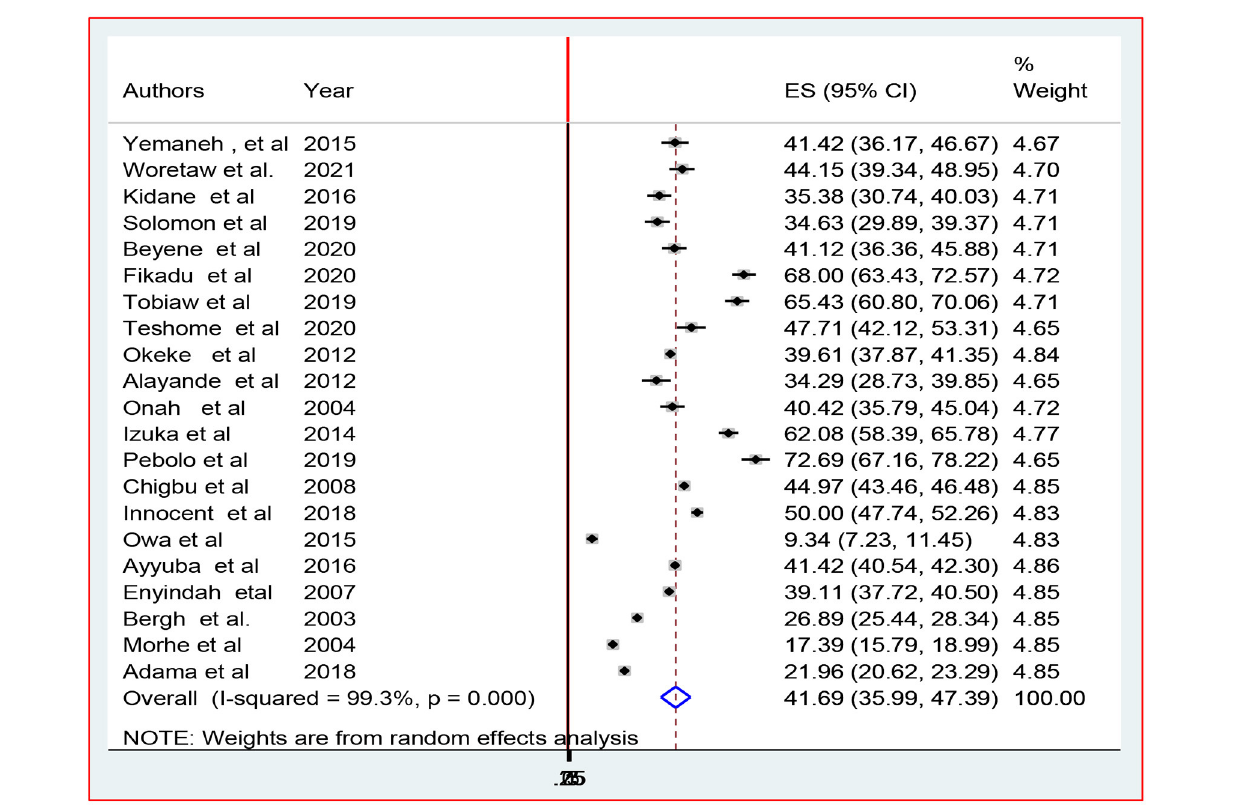
FIGURE 2 | Overall pooled prevalence of episiotomy practice in Africa,